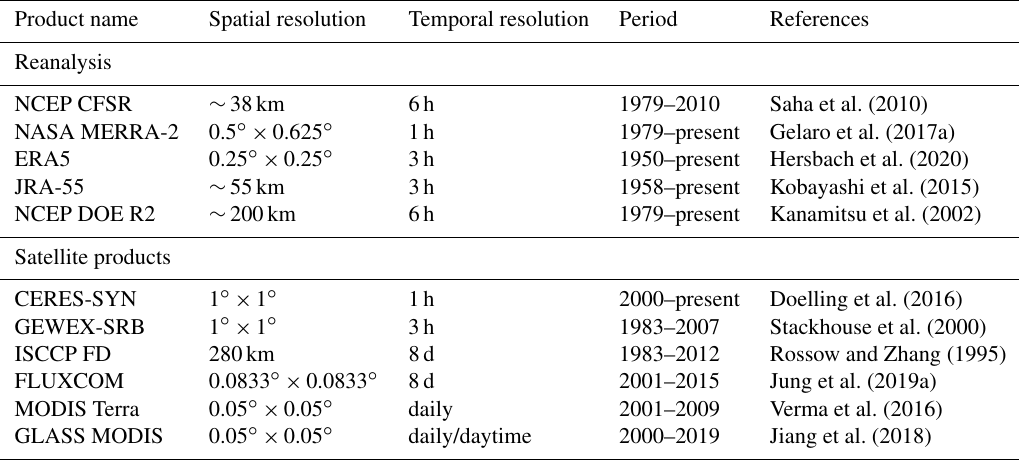
Table 1. Summary of available R n